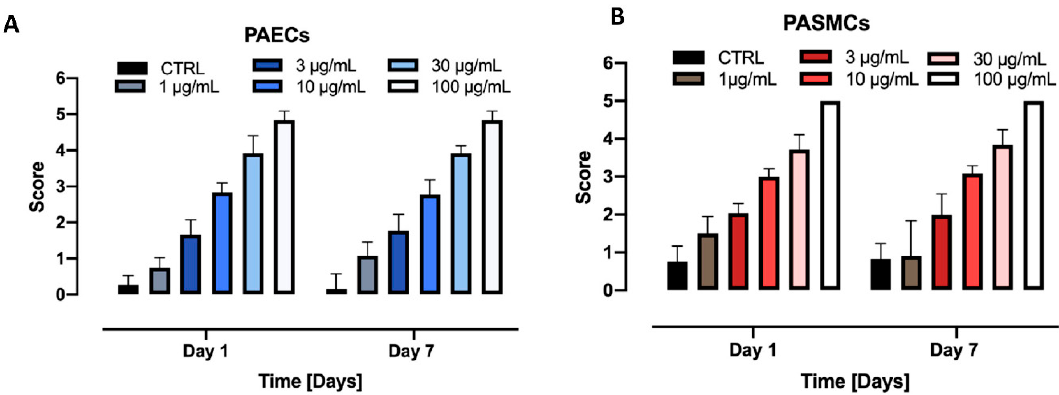
Figure 5. Blind scoring of nanoMIL-89. Cells were treated with di ff erent concentrations of nanoMIL-89 (1, 3, 10, 30, 100 µ g / mL) and imaged with inverted light microscope. Cellular uptake of nanoMIL-89 by ( A ) PAECs and ( B ) PASMCs was determined by blinded visual scoring ( n = 6 independent assessments) according to a relative scale from 0 to 5.